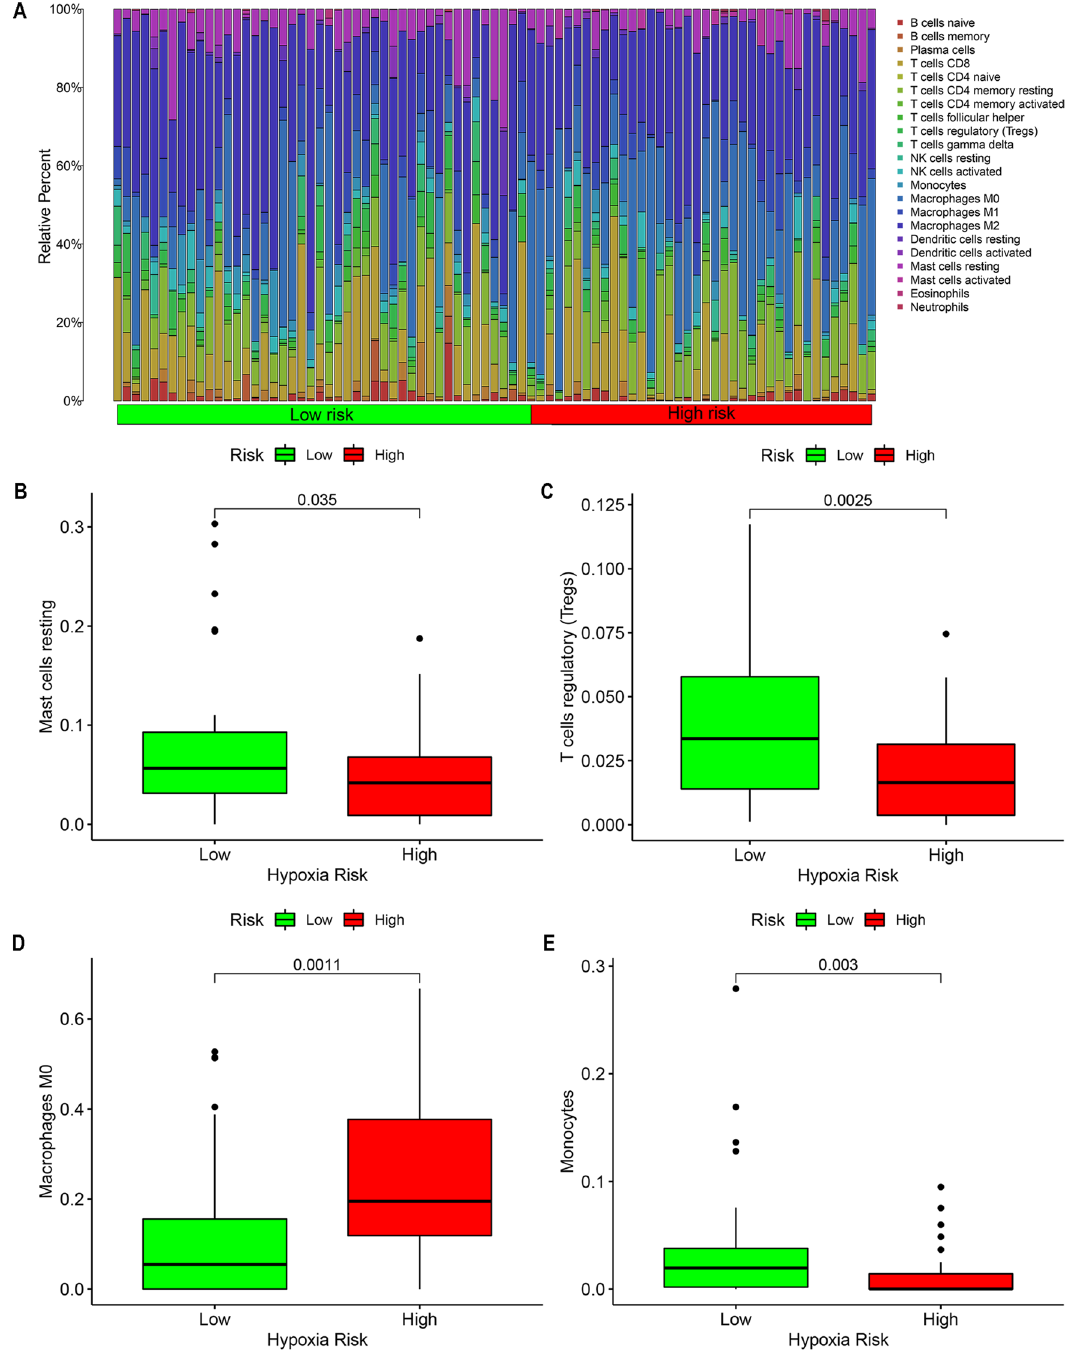
Figure 5. The difference in immune cell infiltration between the high-risk group and the low-risk group. ( A ) Heat map quantifying the degree of immune cell infiltration in the sample. ( B - E ) There are immune cells with different infiltration in the high-risk group and the low-risk